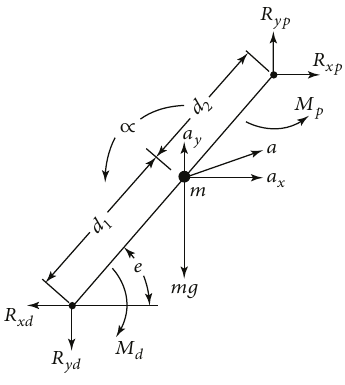
Figure 2: Complete free-body diagram of a single limb segment, showing the reaction and gravitational forces, net moments of force, and all linear and angular